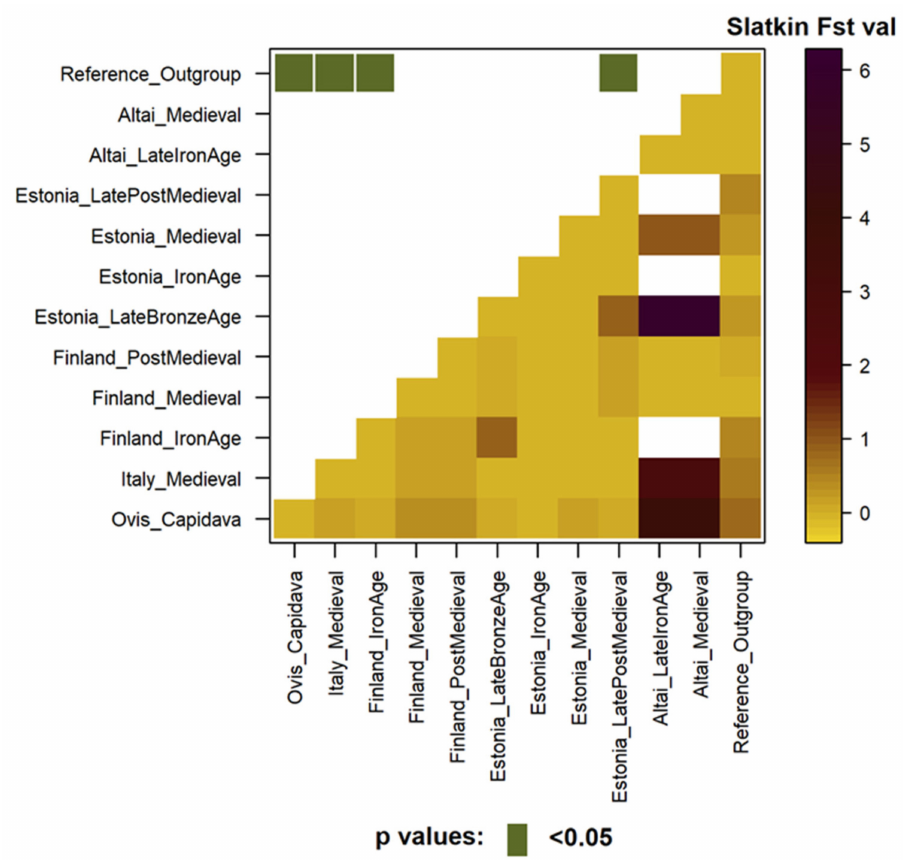
Figure 3. Heatmap displaying the genetic distances between the Capidava population and 41 ancient sequences grouped according to geographical origin and historical period. Slatkin’s Fst values ranging from 0 to 6 are color-coded, with yellow shades indicating low genetic distance and red and purple shades indicating high genetic distance. Blank squares indicate inconclusive results. The analysis was performed on a 304 bp region, nucleotide positions 16099 to 16402